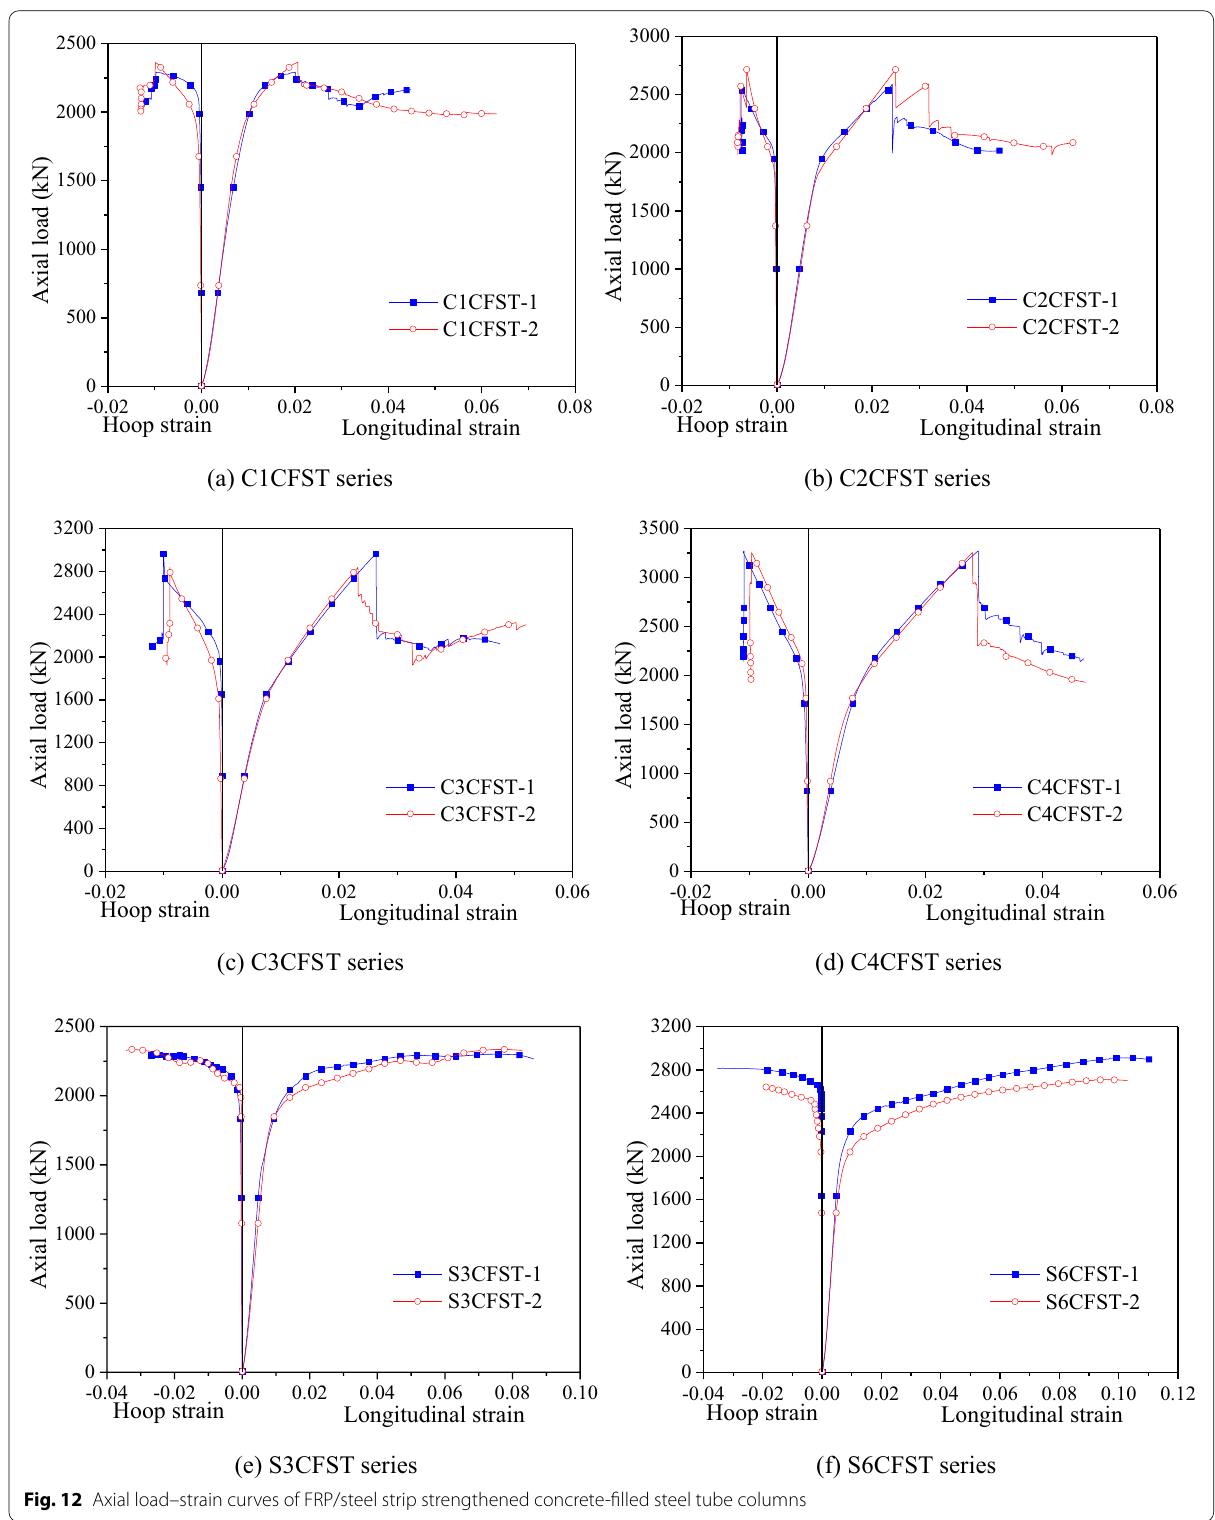
Fig. 12 Axial load–strain curves of FRP/steel strip strengthened concrete-filled steel tube